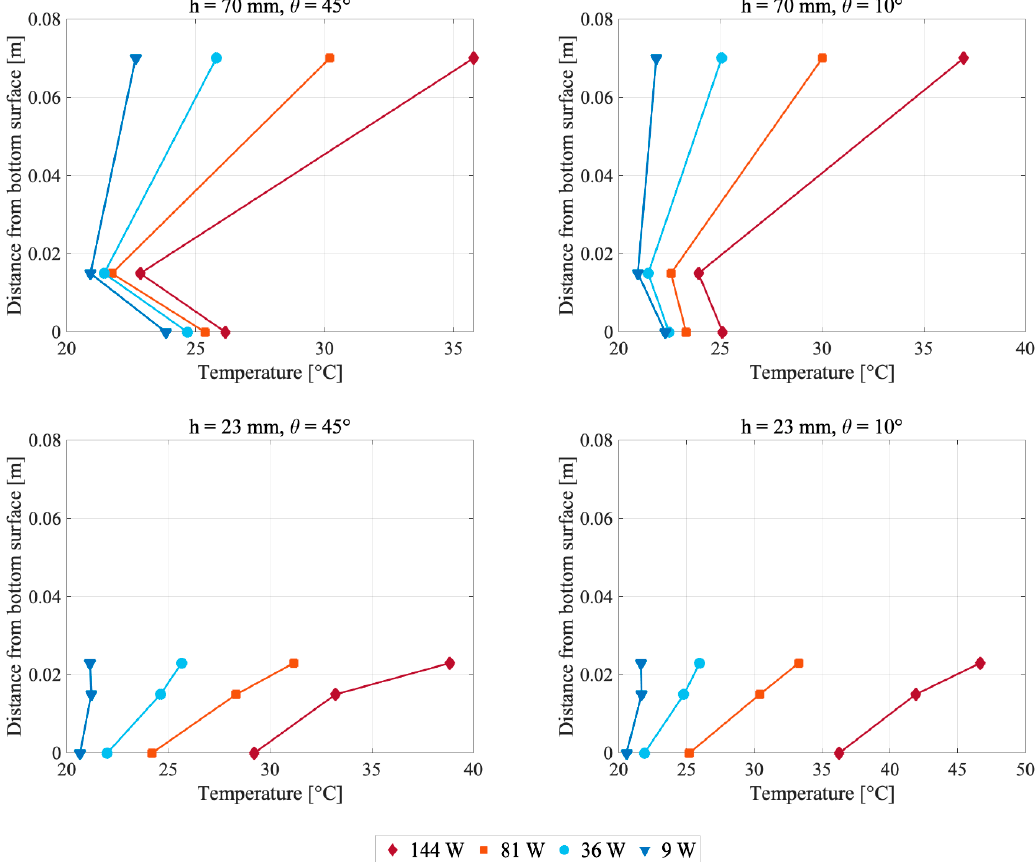
Figure 6. Temperatures ( ◦ C) as a function of distance from the bottom unheated surface (m). Each plot represents a given air cavity height (h) and roof inclination ( θ ).